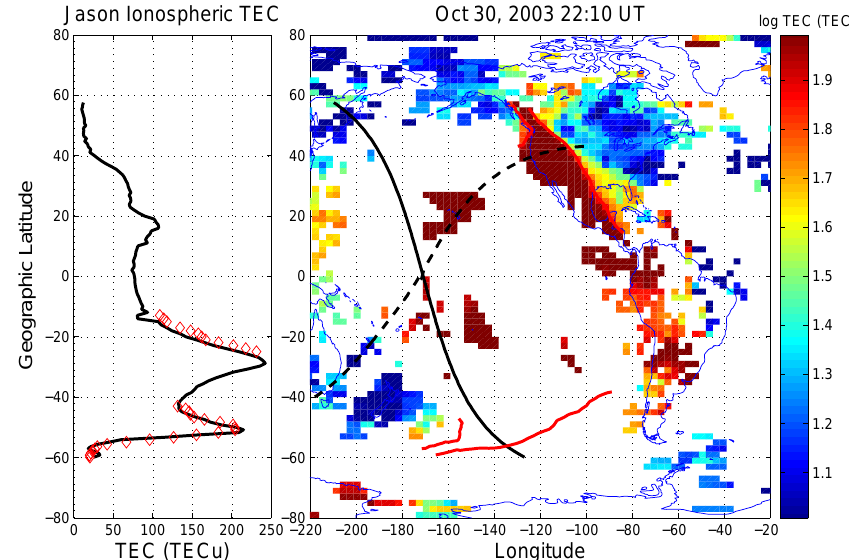
Fig. 2. Characteristics of the strong SED plume ( > 200TECu) seen over the U.S. mainland and at its magnetic conjugate are similar for the 30 October 2003 superstorm indicating the conjugate actions of magnetospheric electric fields mapping along field lines between hemispheres. The closely-similar magnitude of TEC in the two hemispheres suggests a similar source for the TEC enhancements at low and mid latitudes during that